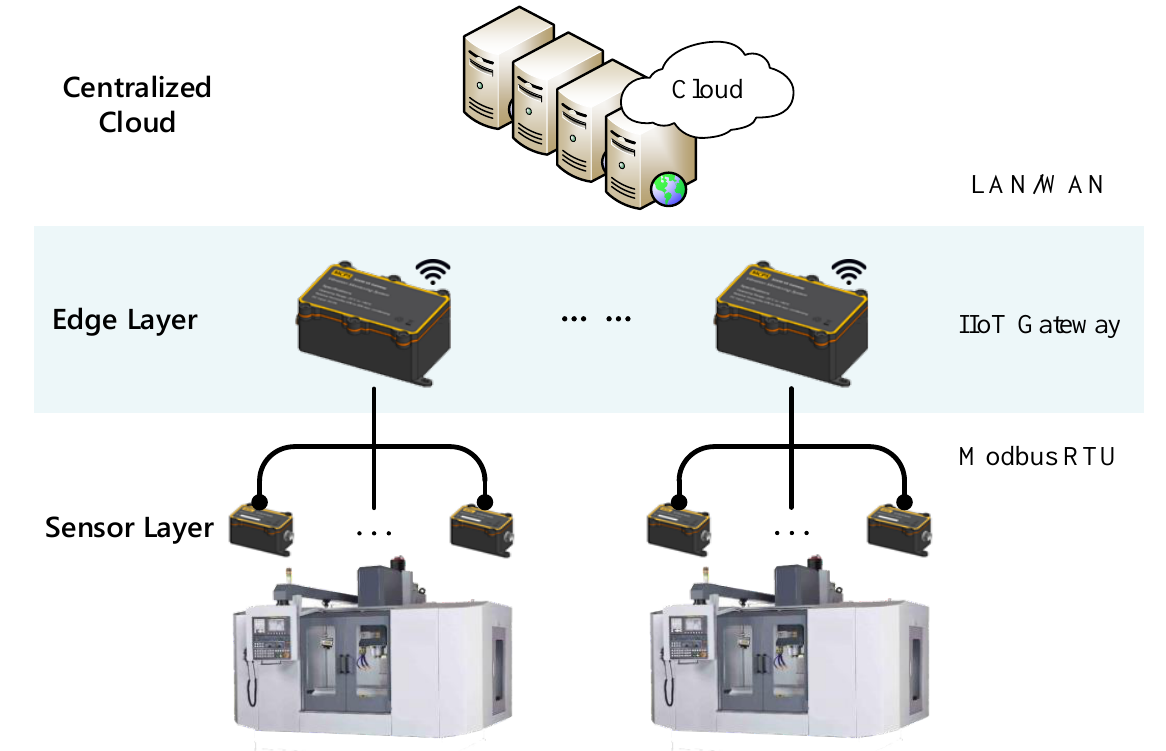
Figure 1. Overall architecture of an edge-to-cloud based IIoT condition monitoring system.